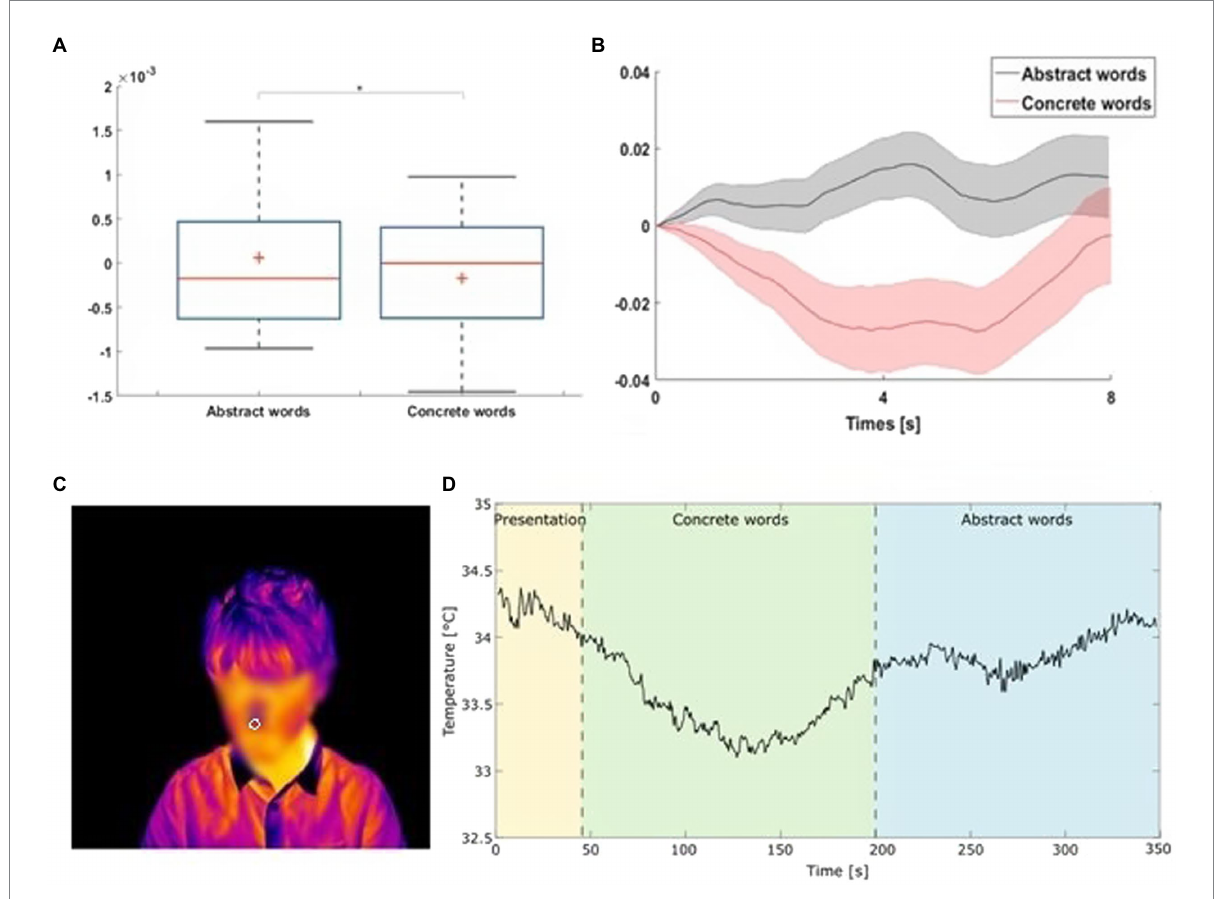
FIGURE 2 Panel (A) Slopes of the nasal tip temperature during abstract and concrete word presentation. Statistical analysis resulted in a significant difference between the two conditions [ F (1,461) = 4.108, p = 0.0432]. Listening abstract words induced an increased (positive) slope of the thermal signal in comparison to concrete words. Horizontal lines in the boxes indicate the median, upper and lower borders indicate I and III quartile, “whiskers” extend to the farthest points that are not outliers, dots represent outlier trials. Panel (B) Average nasal tip temperature trend during abstracts and concrete word conditions across repetitions. The shadowed colored areas represent the standard error of each curve. Panel (C,D) Thermogram of a representative participant: ROI placement on the nose tip (white circle) and the associated thermal signal after being visually inspected and corrected for motion artifacts. The first dashed line represents the beginning of the trial relating to concrete words and the second one represents the end of the concrete words and the beginning of abstract